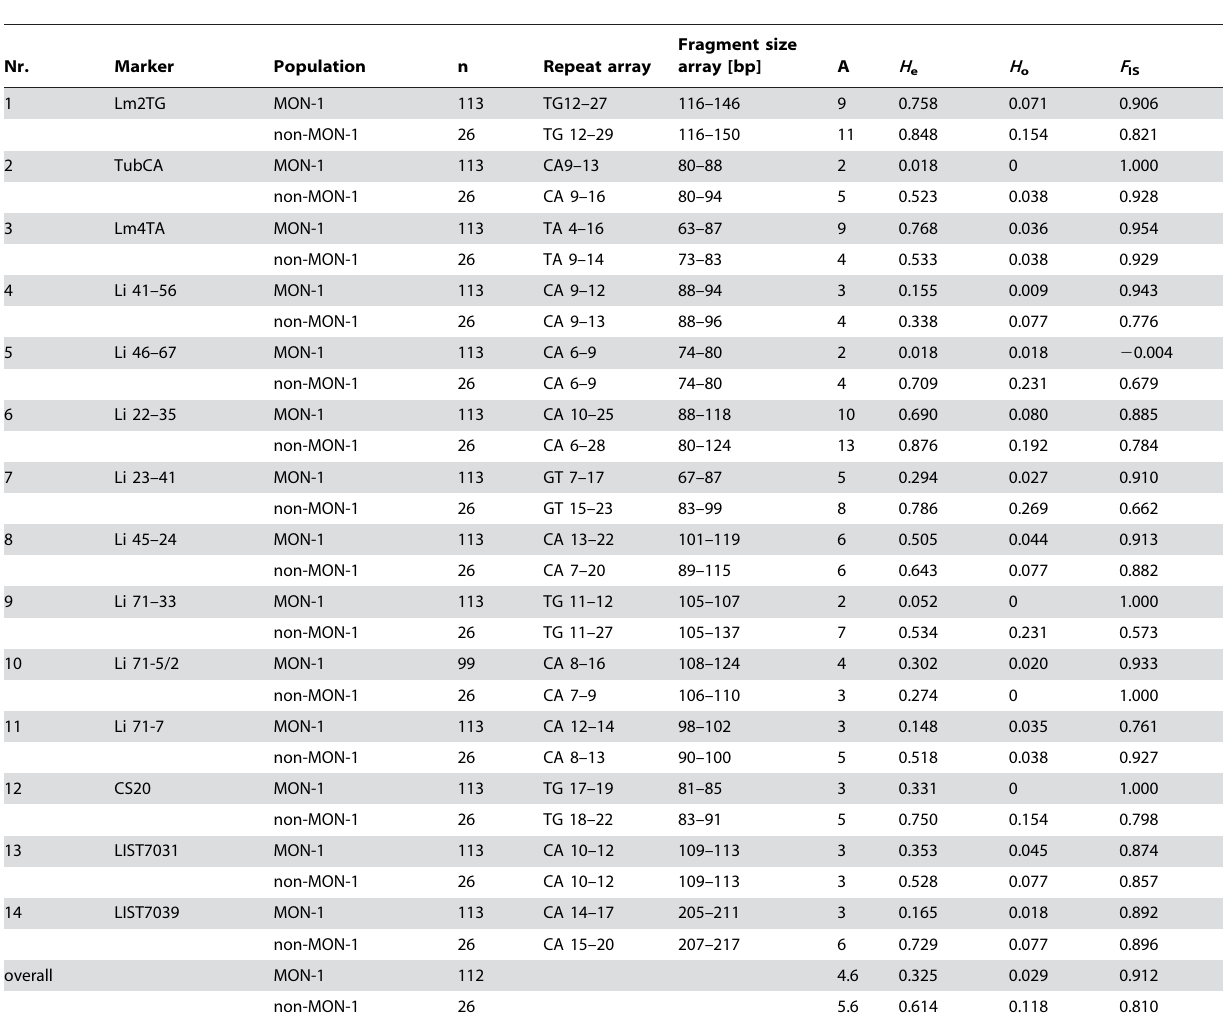
Table 2. Characteristics of the 14 microsatellite markers used for population analysis of Mediterranean Leishmania infantum